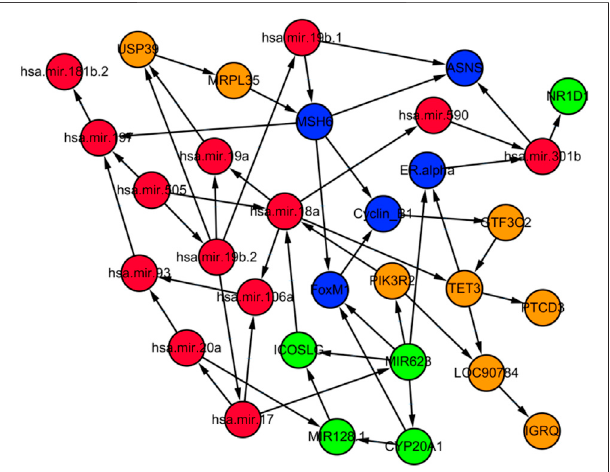
FIGURE 5 | The BN structure learned by GRASP using multiple different genomic features which are highly correlated with the expression of LOC90784. Orange nodes: mRNA transcripts; Red nodes: microRNAs; Blue nodes: protein expressions; Green nodes: DNA